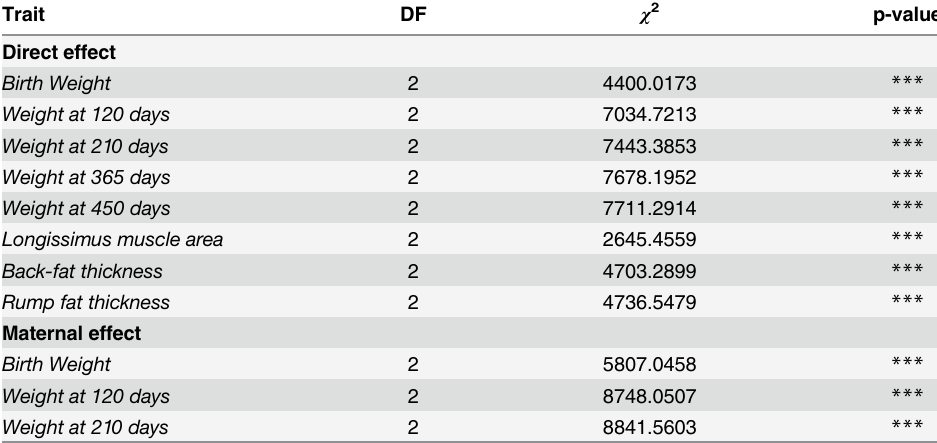
Table 9. Kruskal-Wallis rank sum test and Dunn ’ s test for multiple pairwise comparisons of expected progeny differences for weights and carcass traits among the clusters. Trait p-value Direct